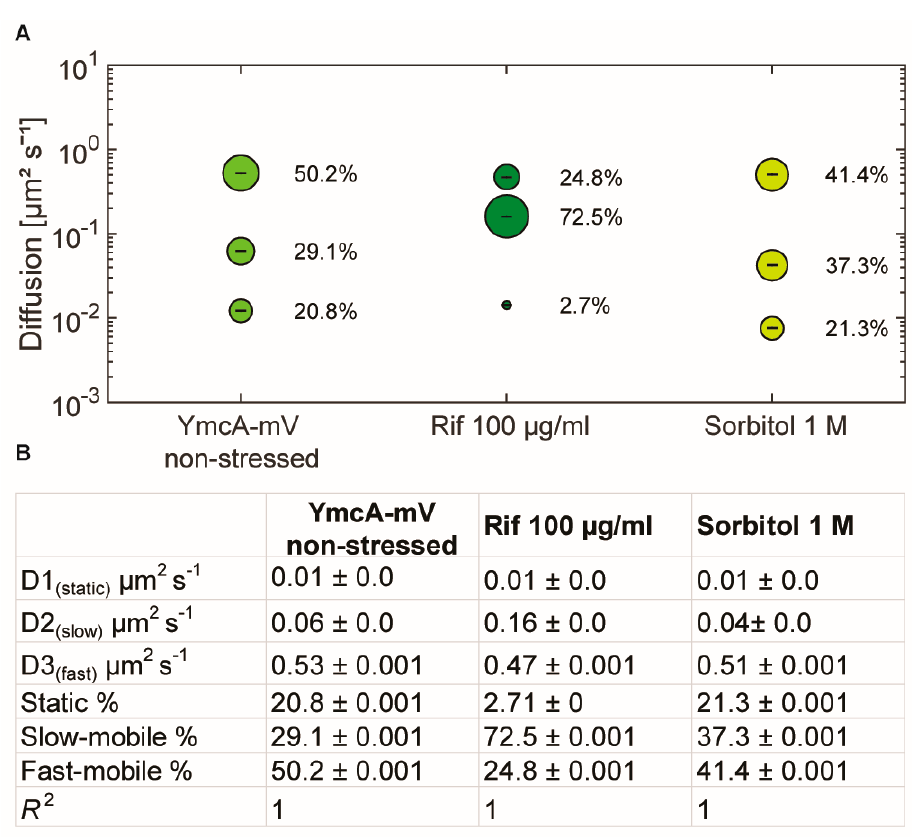
Figure 5. Squared displacement analyses of YmcA single-molecule dynamics. ( A ) bubble plot showing fractions sizes and their corresponding diffusion constants, “Rif” indicates cells treated with 100 µg/ml of rifampicin for 15 min, “Sorbitol” indicates cells incubated with 1 M sorbitol for 30 min. ( B ) Data from SQD analyses.